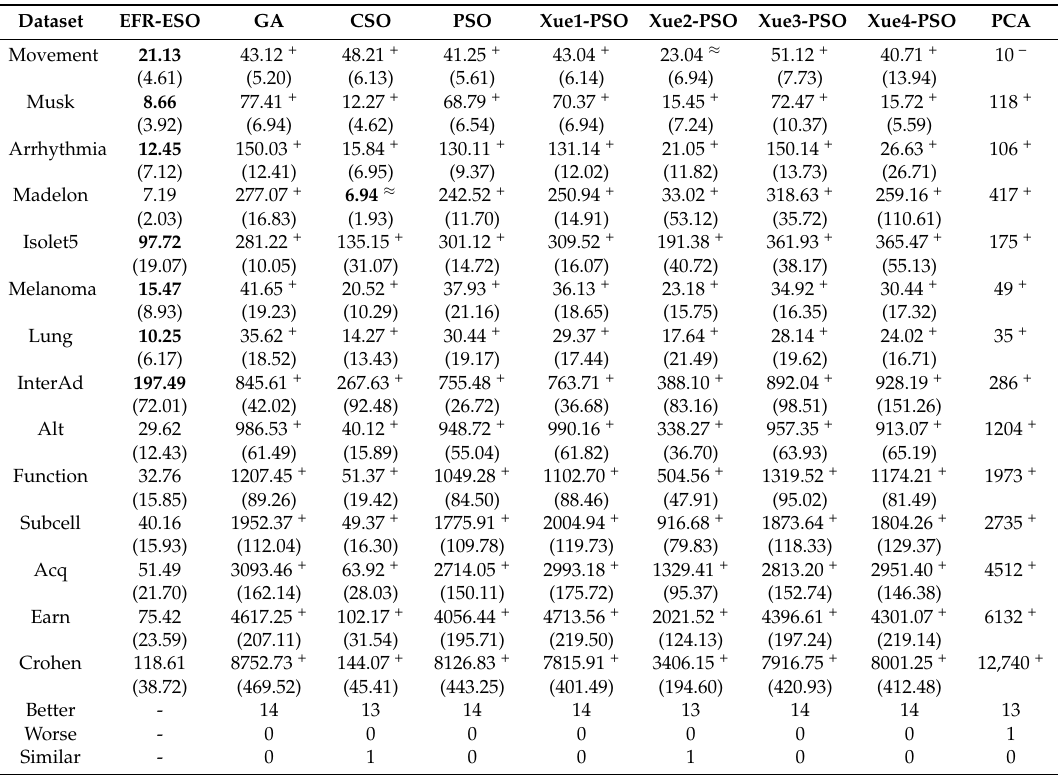
Table 3. Average number of selected